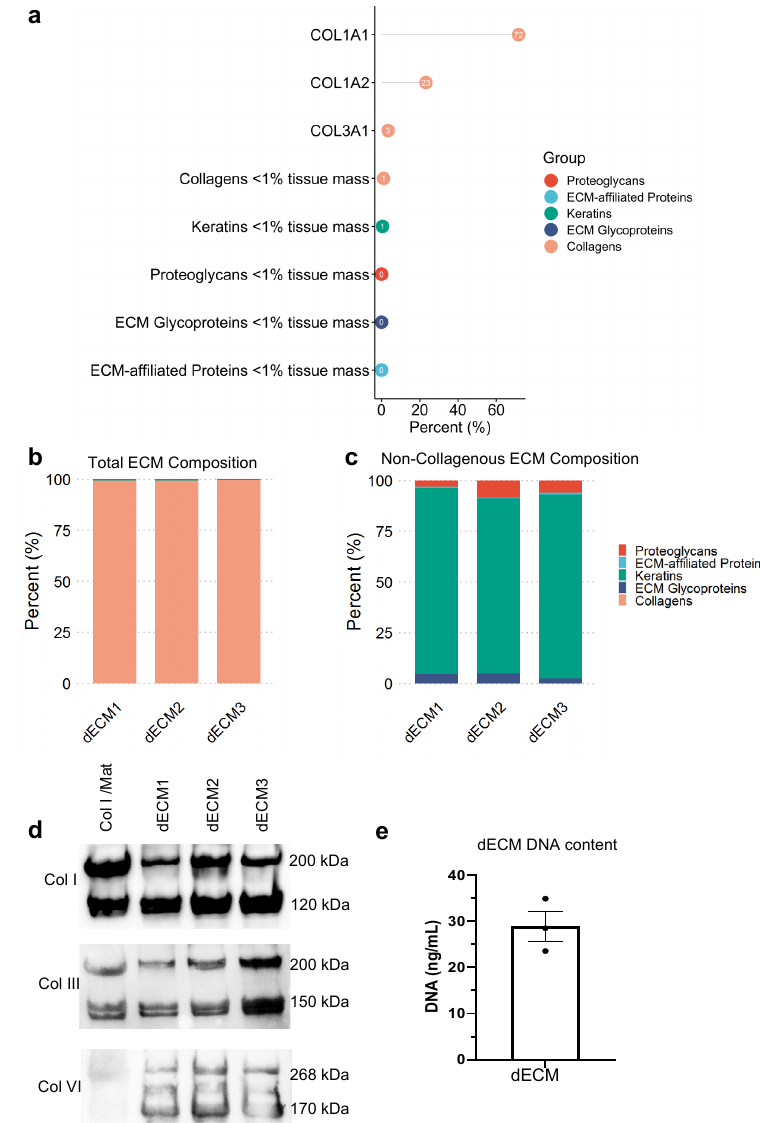
Figure 1. dECM protein composition and DNA content. ( a ) Mass spectrometry analysis of the percent abundance of matrisome proteins in the dECM in the order of abundance as an average of two technical repeats of dECM from three animals. The percent abundance of matrisome proteins across the three batches of dECM, including ( b ) and excluding ( c ) the dominating collagen proteins. ( d ) The collagen content assessed and validated using Western blot analysis, demonstrating the presence of types I, III, and VI collagen in 10 mg mL − 1 of dECM compared to a collagen I/Matrigel matrix. ( e ) Quantification of residual DNA content using PicoGreen assay. Error bar represents standard error of the mean (SEM) of three technical replicates of one batch of dECM.